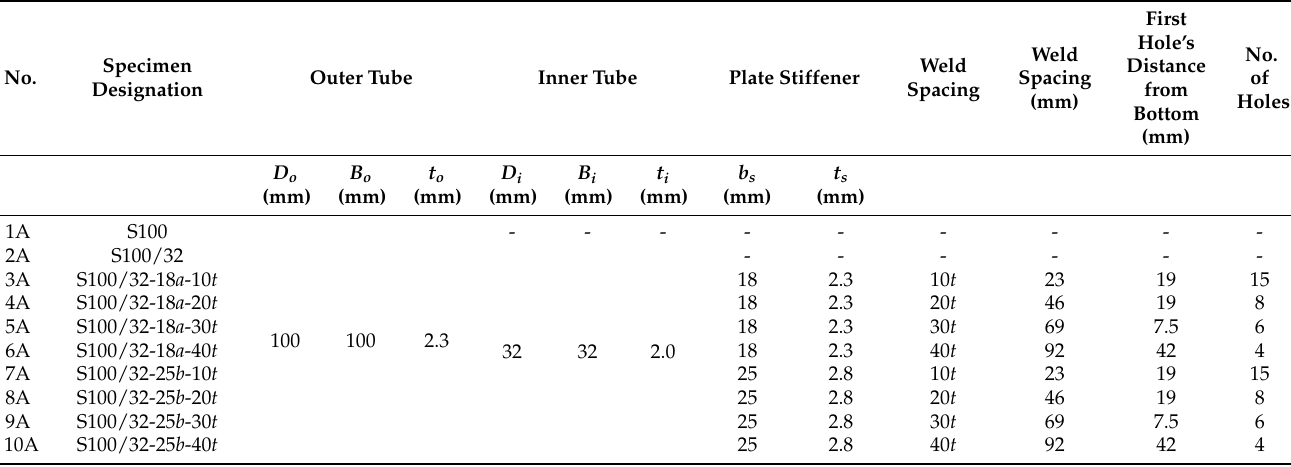
Table 1. Specifications for the square CFDST.